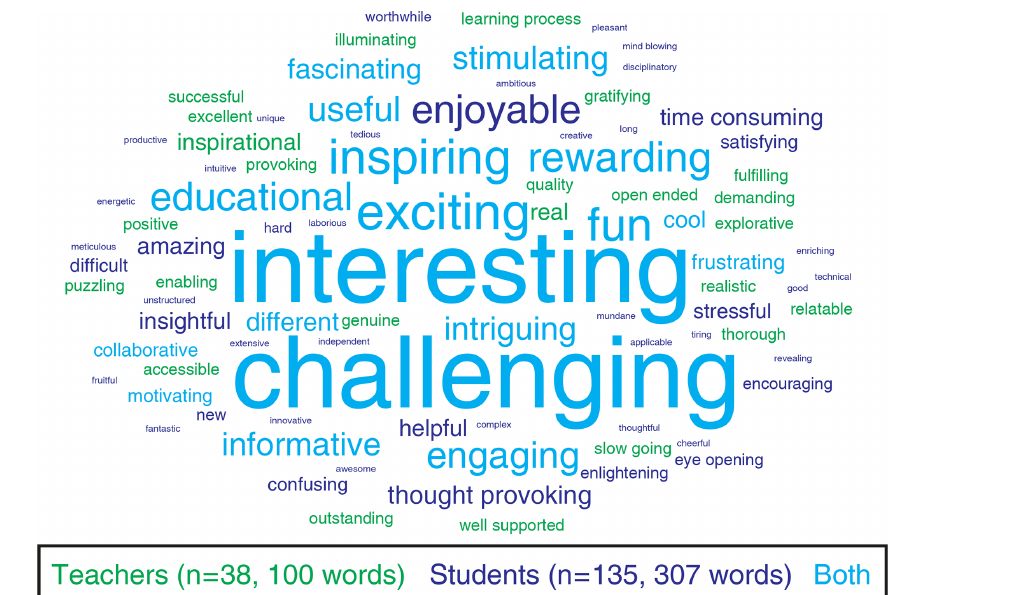
Figure 4. Word cloud of students’ experiences. Colours indicate words identified by students (blue), teachers (green), or both (cyan). Students and teachers have been given equal total